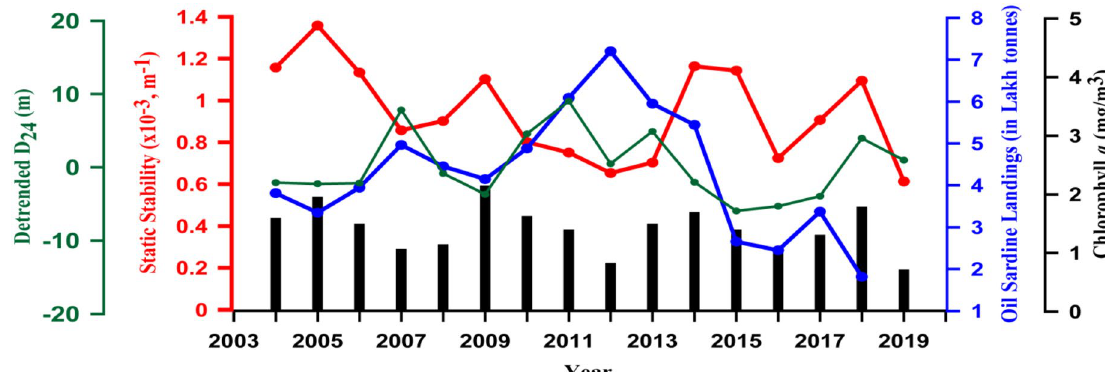
Figure 8. Time series of annual oil sardine landing (lakh tonnes, blue solid line), static stability (m −1 , red solid line) in the upper 15 m of the water column, de-trended D 24 (m, green solid line), and chlorophyll a (mg/m 3 , black solid line) from 2004 to 2019. The static stability, de-trended D 24, and the chlorophyll a were averaged over the boxes (8° to 12° N) and for the period from June to September. See Fig. 2 for the location of boxes.